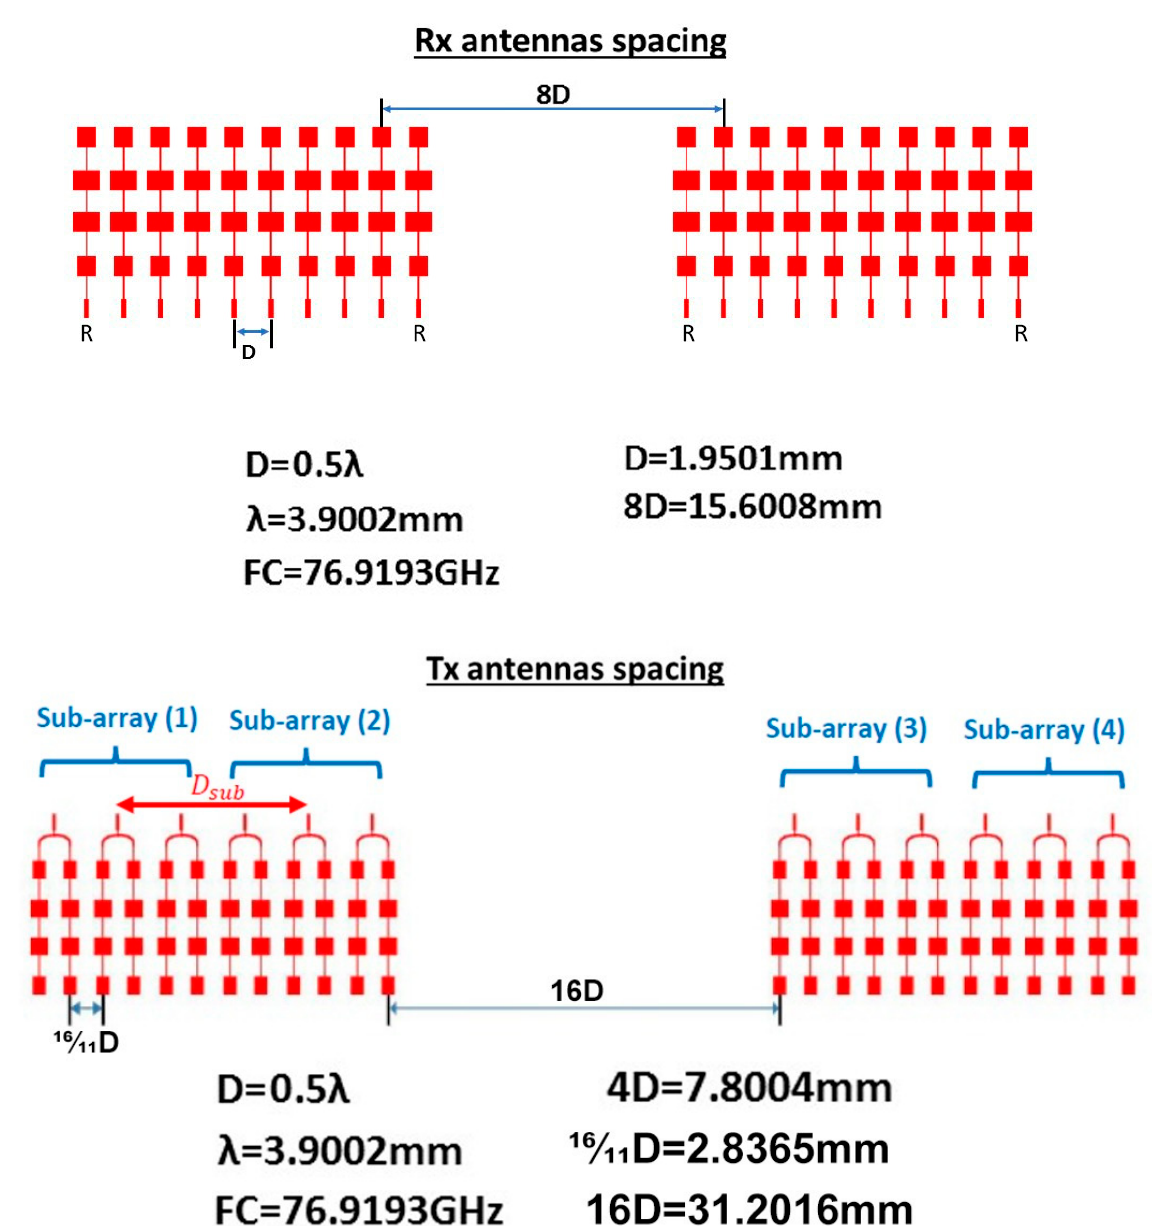
Figure 12. Proposed array configurations for the LFMCW radar ( a ) transmitter array and ( b ) receiver